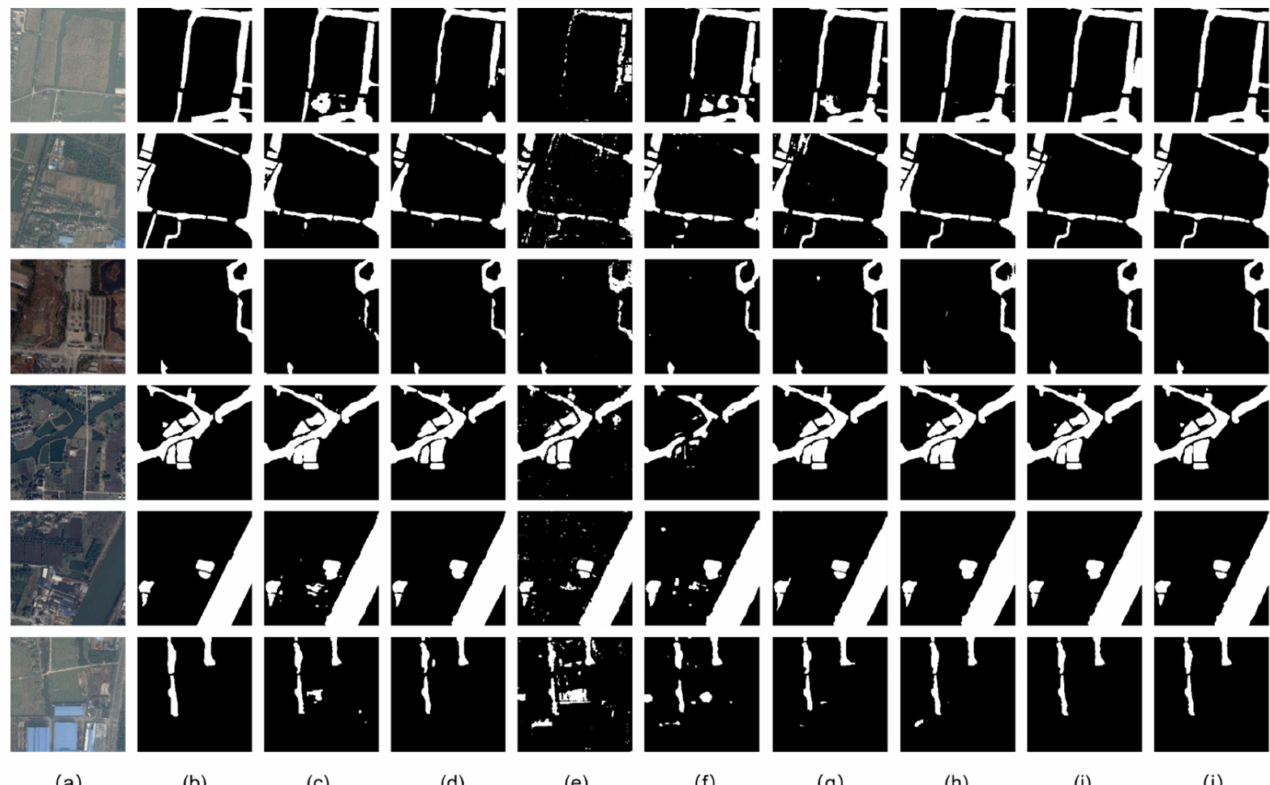
Figure 8. Visible water-body detection of the 2020 Gaofem Challenge water-body segmentation dataset. ( a , b ) Raw images and ground truth, respectively. ( c , d ) The results of LinkNet and the results of HR-Net, respectively. The results of FCN and the results of DeepLab V3+ are shown in ( e , f ), respectively. ( g ) The results of MECNet, and ( h ) the results of our MSResNet. The results of our proposed MSResNet via rotation transformation learning and flip transformation learning are displayed in ( i , j ),